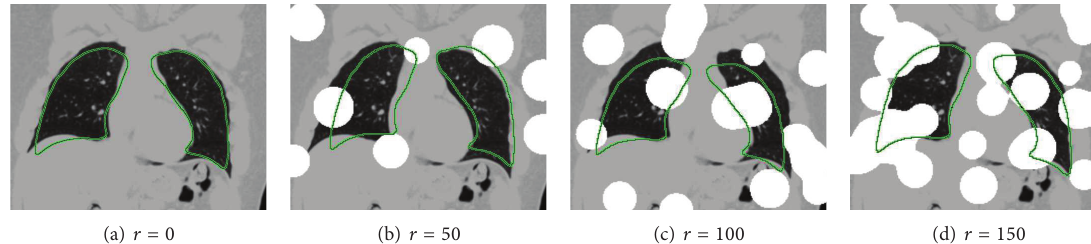
Figure 5: ASM initializations (green contour) and final segmentations (yellow contour) across different test sets. (a)–(f) Result of other methods for comparison with results produced with the proposed method (g)–(l).